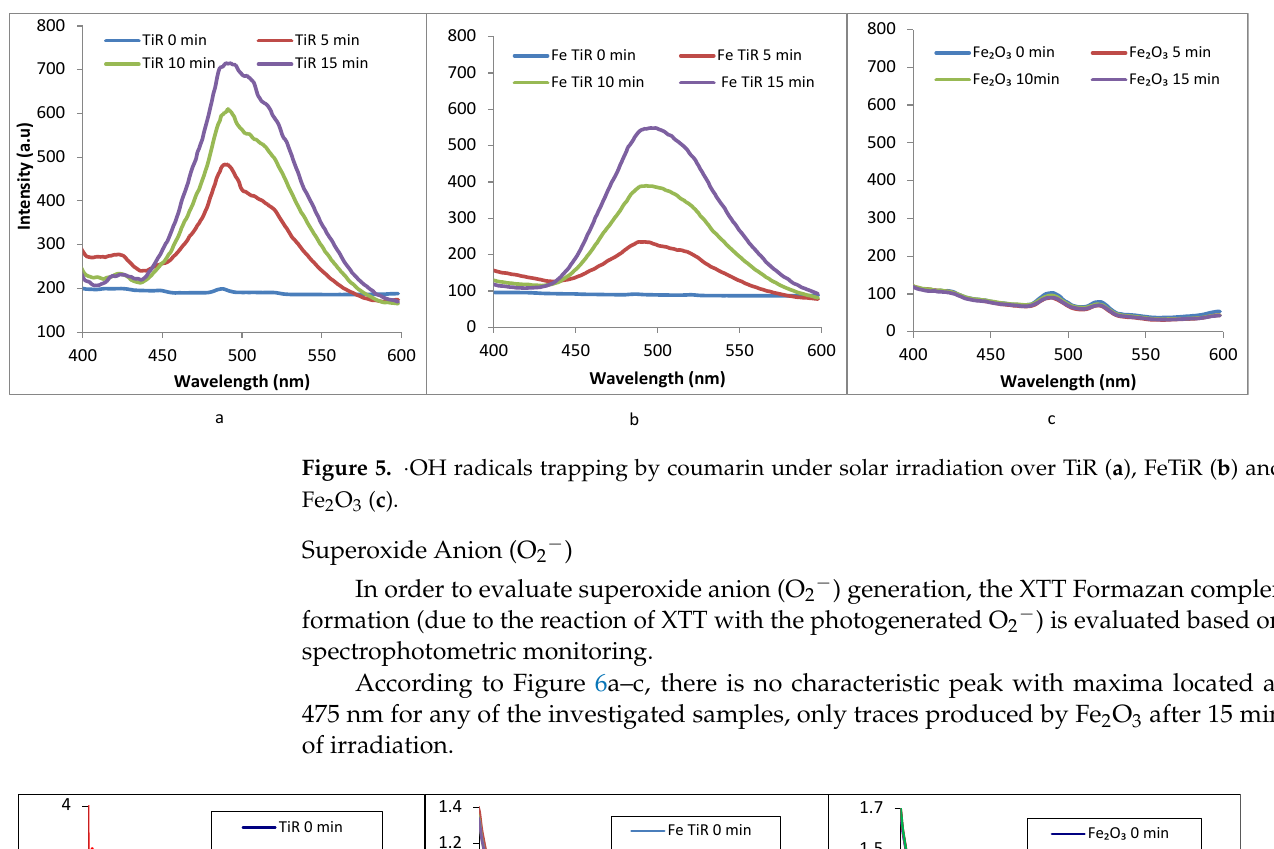
Figure 7. The electrokinetic potential of TiRs, Fe-modified TiRs and Fe 2 O 3 cubes suspended in de- ionised water and diluted ammonia solution.